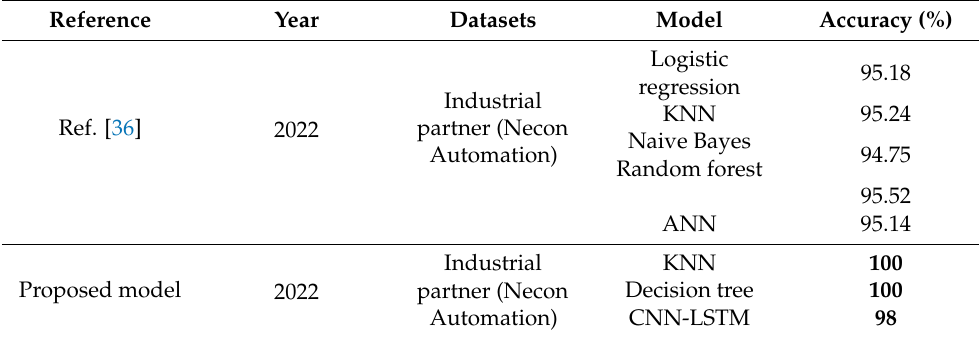
Table 15. Comparison of the proposed system with the system that developed the dataset.